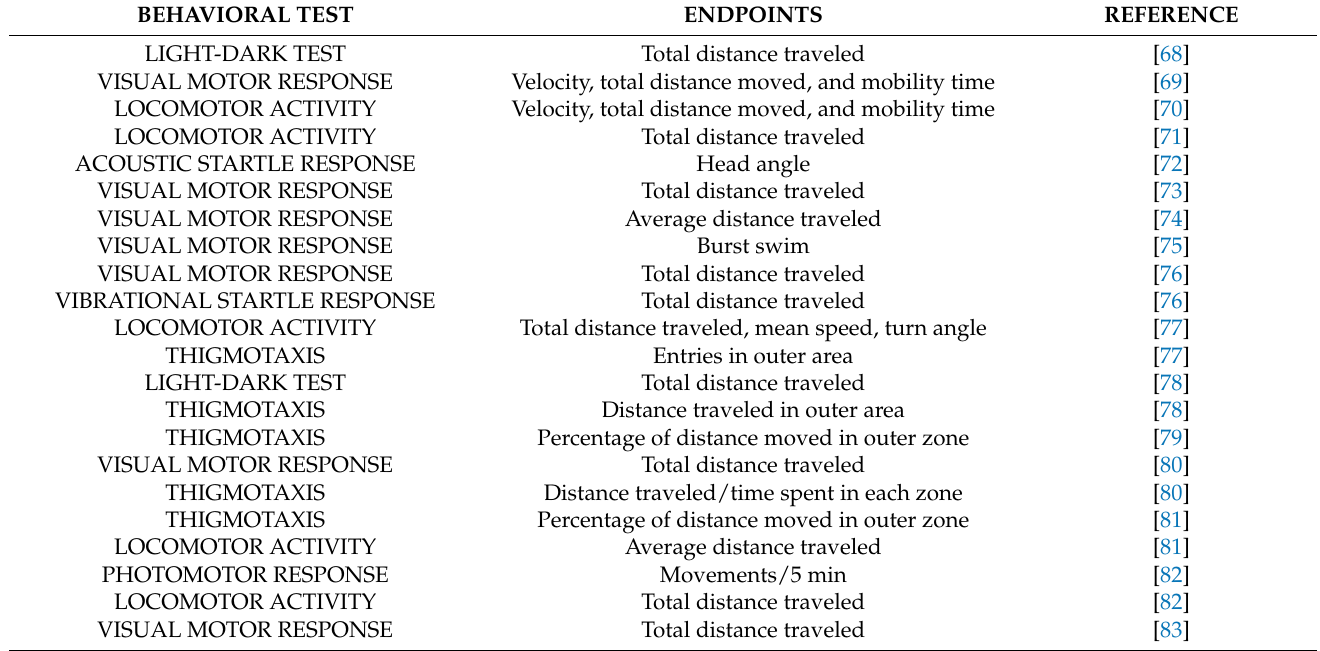
Table 1. Selected studies using zebrafish larvae as experimental model in behavior